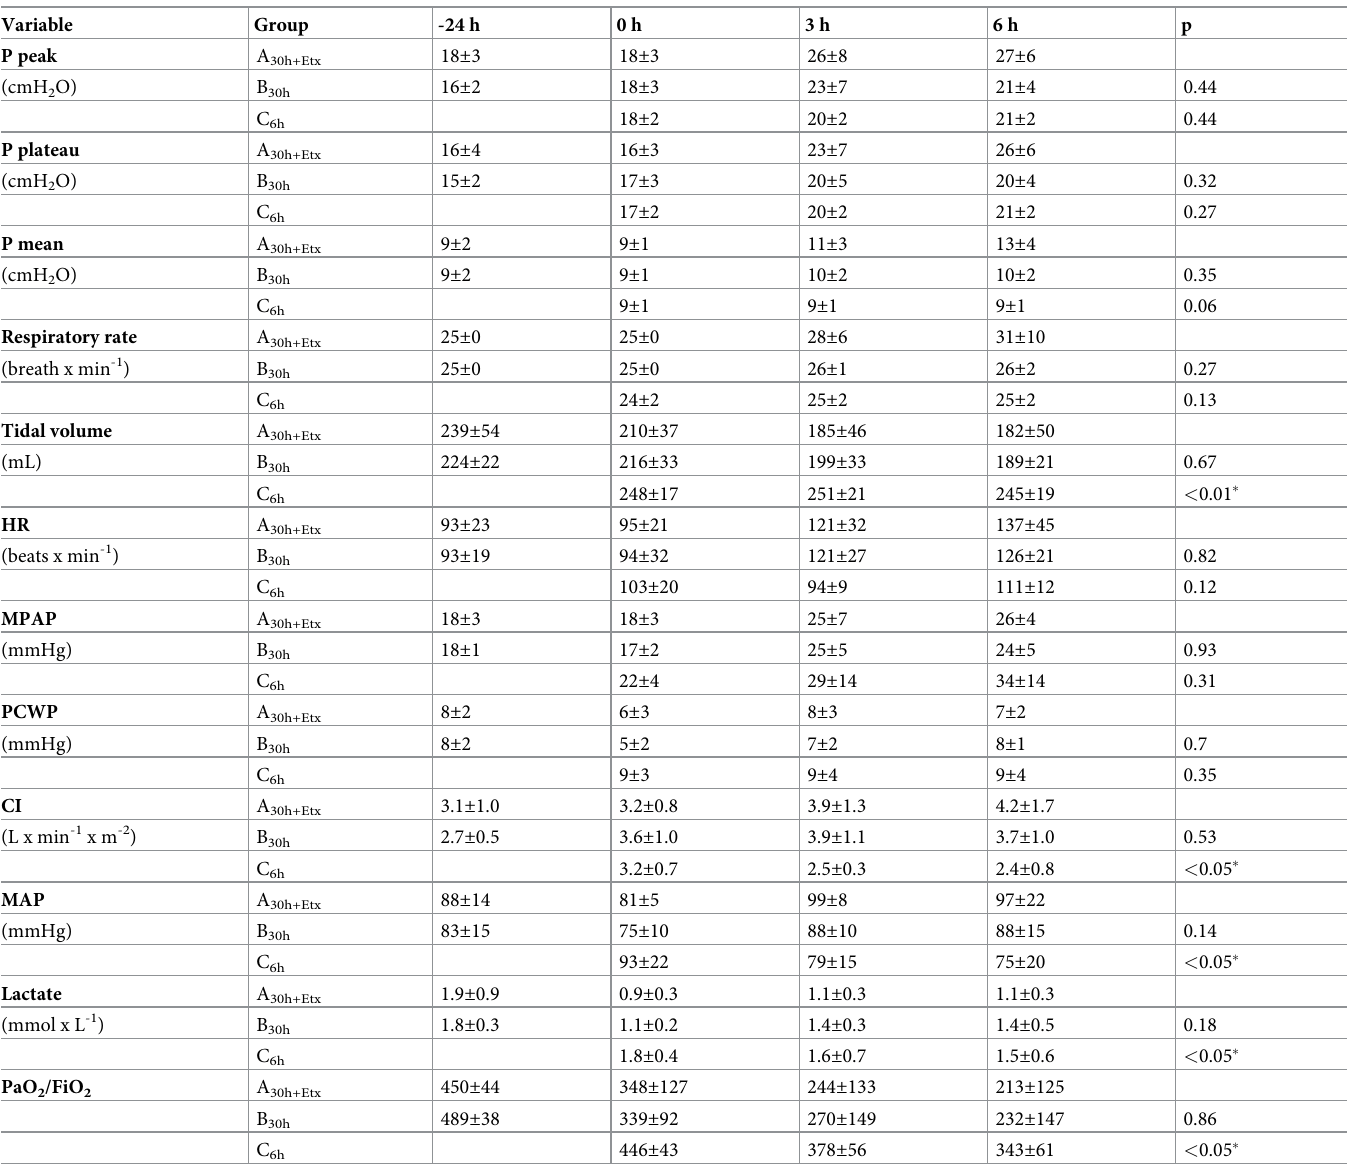
Table 3. Physiologic variables, hypoperfusion and lung injury.